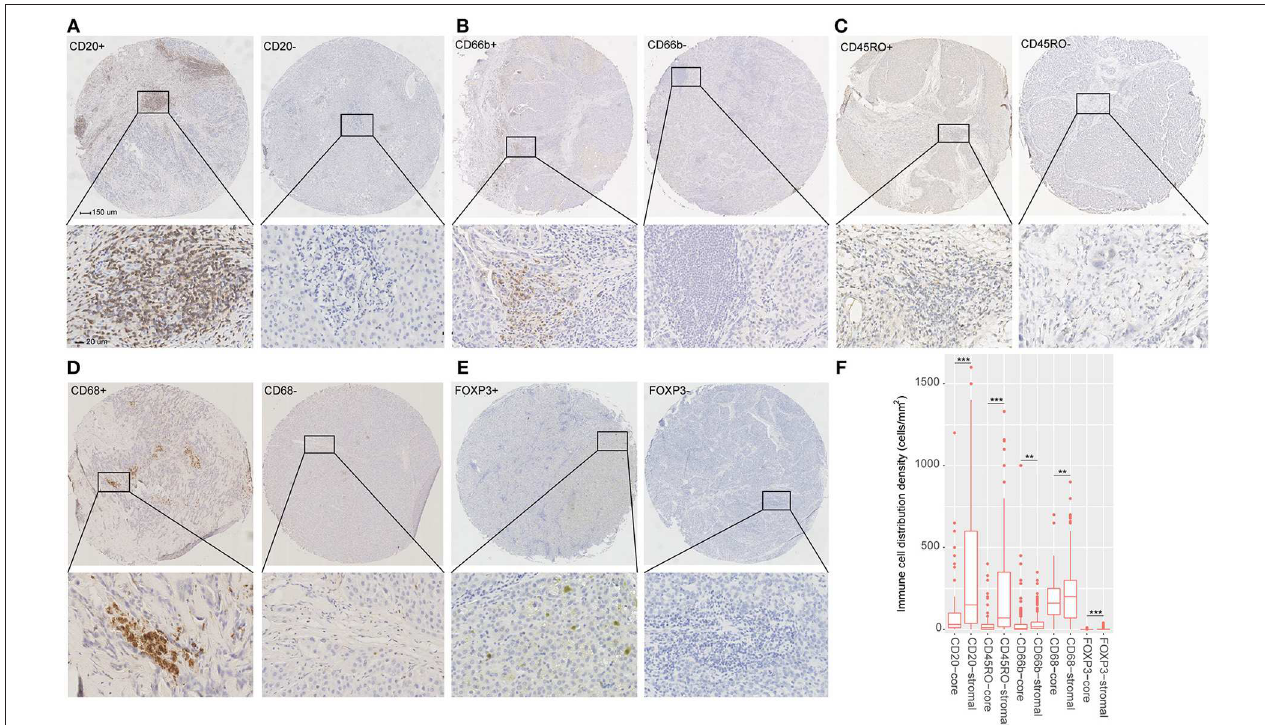
FIGURE 2 | (A–E) Tumor infiltration of B cells, neutrophils, Memory T cells, macrophages and regulatory T cells (Tregs) in HCC patients. (F) Tumor infiltration density of B cells, neutrophils, Memory T cells, macrophages and Tregs in the total cohort (testing and validation cohorts). The mean values of infiltration density of B cells, neutrophils, Memory T cells, macrophages and Tregs in stroma are 331, 37, 155, 199, and 2 cells/mm 2 . The standard deviation of infiltration density of B cells, neutrophils, Memory T cells, macrophages and Tregs in stroma are 343, 62, 198, 127, and 4 cells/mm 2 . ** P < 0.01; *** P <